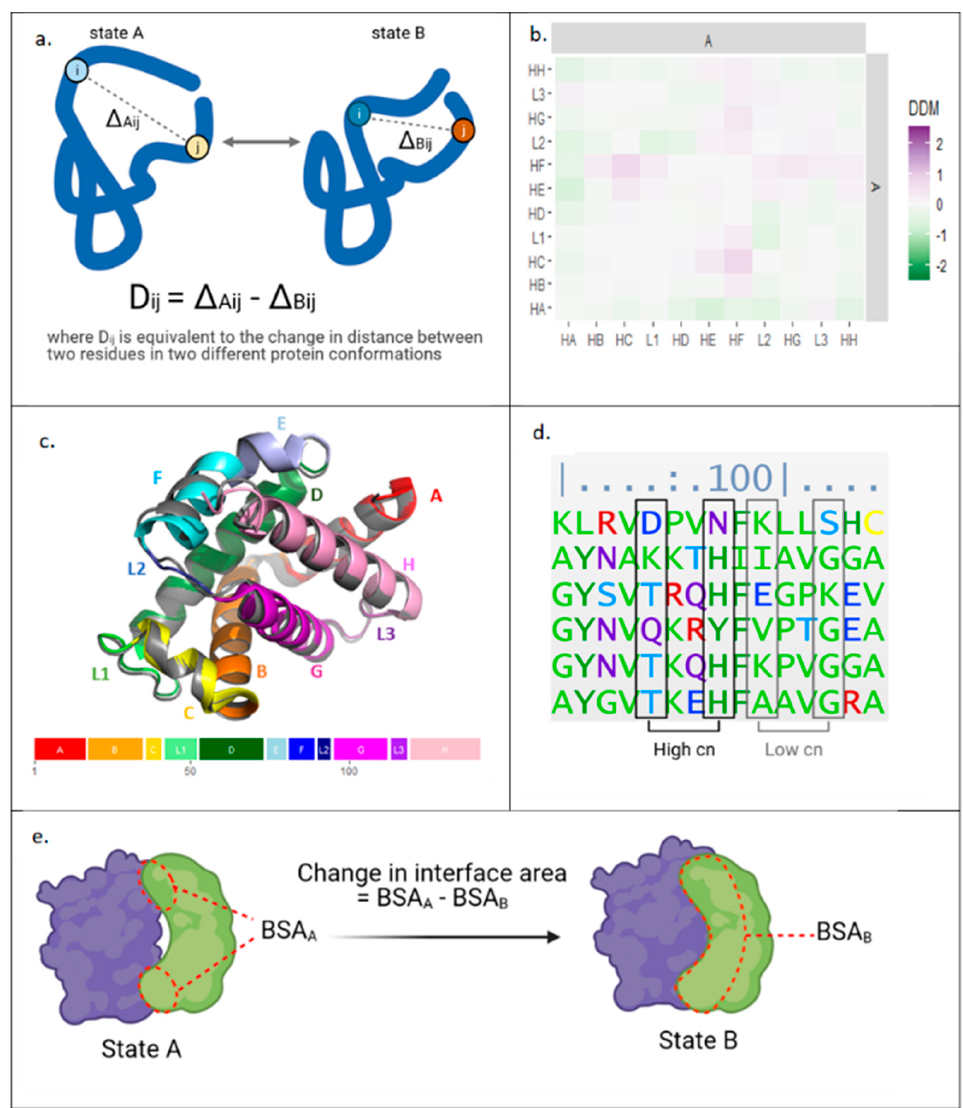
Figure 2. Bioinformatic approaches applied herein to study protein allostery. ( a ) Calculation of difference distance matrices (DDM) data from structures of a protein in two different conformations. ( b ) Block DDM for deoxy- and oxyhemoglobin- α . Squares represent average DDM changes for residues within domains specified. ( c ) Deoxyhemoglobin- α (grey, 1A3N) and oxyhemoglobin- α (multicoloured, 2DN1) aligned with C helices. Oxyhemoglobin- α ’s colours correlate with domain structure shown below. ( d ) Calculation of evolutionary couplings: a section of a multiple sequence alignment for haemoglobin- α . ( e ) Calculation of the change in interface area at dimer interface. HA = helix A, L1 = loop 1, BSA = buried surface area, cn = coupling number, with higher values indicating stronger